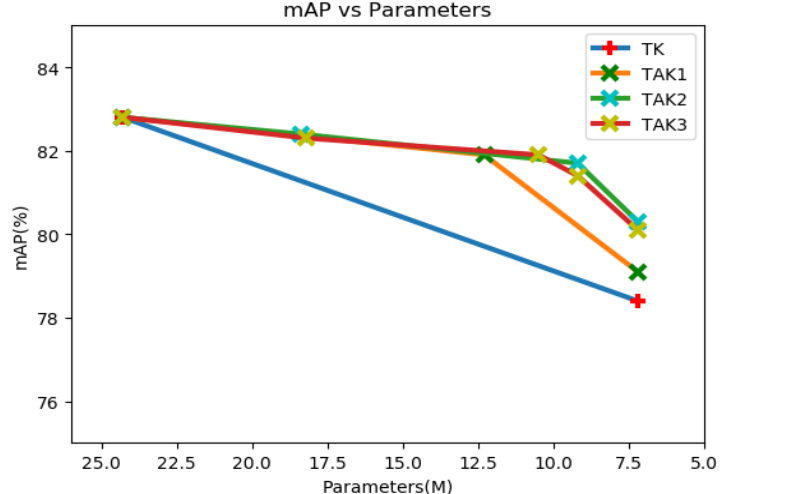
Figure 8. Comparisons with different quantities of TA for